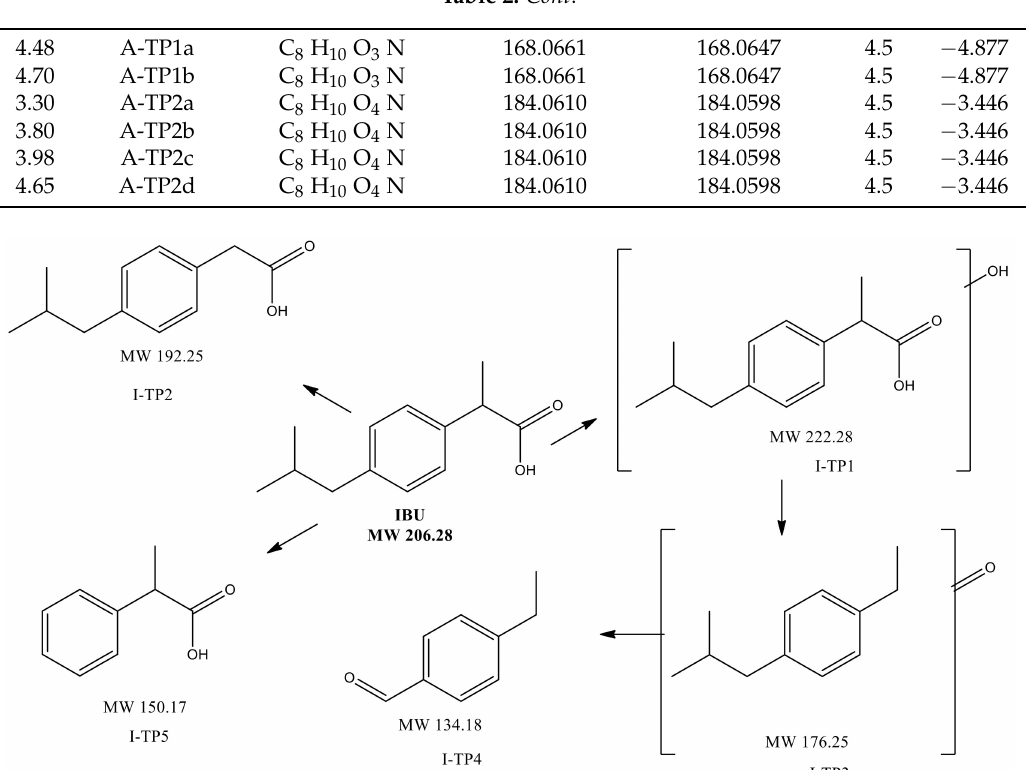
Figure 8. TPs products generated from IBU by PEF/TiO 2 20 wt% under